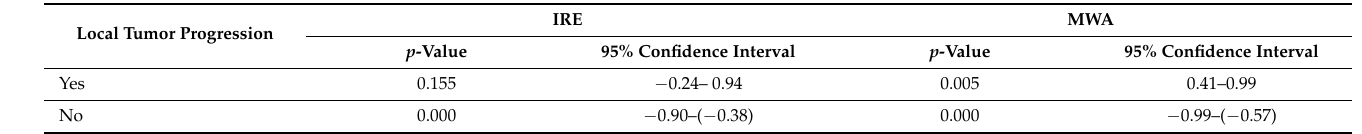
Table 4. Comparison of the mean VIC of the peripheral ablation zone and the VIC of non-ablated liver parenchyma after IRE and MWA in each patient group: Results of the t-test for paired